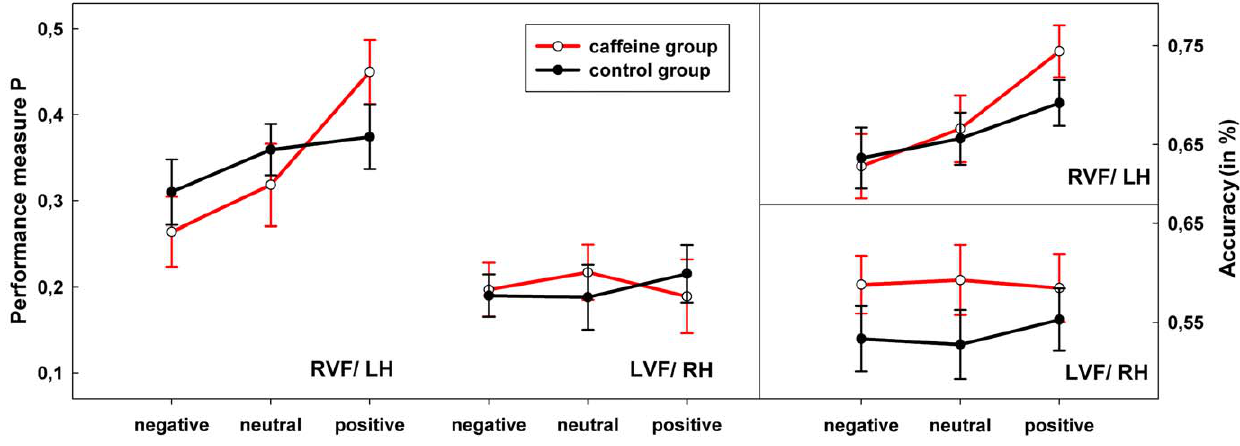
Figure 1. Average signal detection performance measures P and accuracy per condition and experimental group. Error bars represent the standard error of the mean. RVF/LH = right visual field/left hemisphere, LVF/RH = left visual field/right hemisphere.